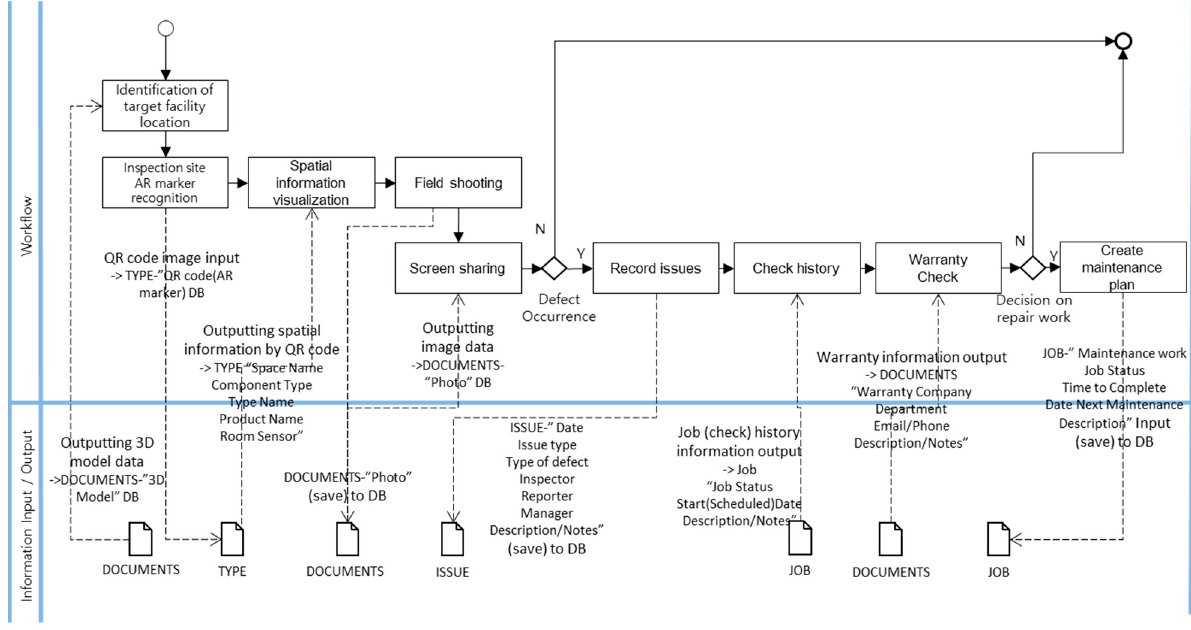
Figure 7. Daily or routine inspection BPMN.